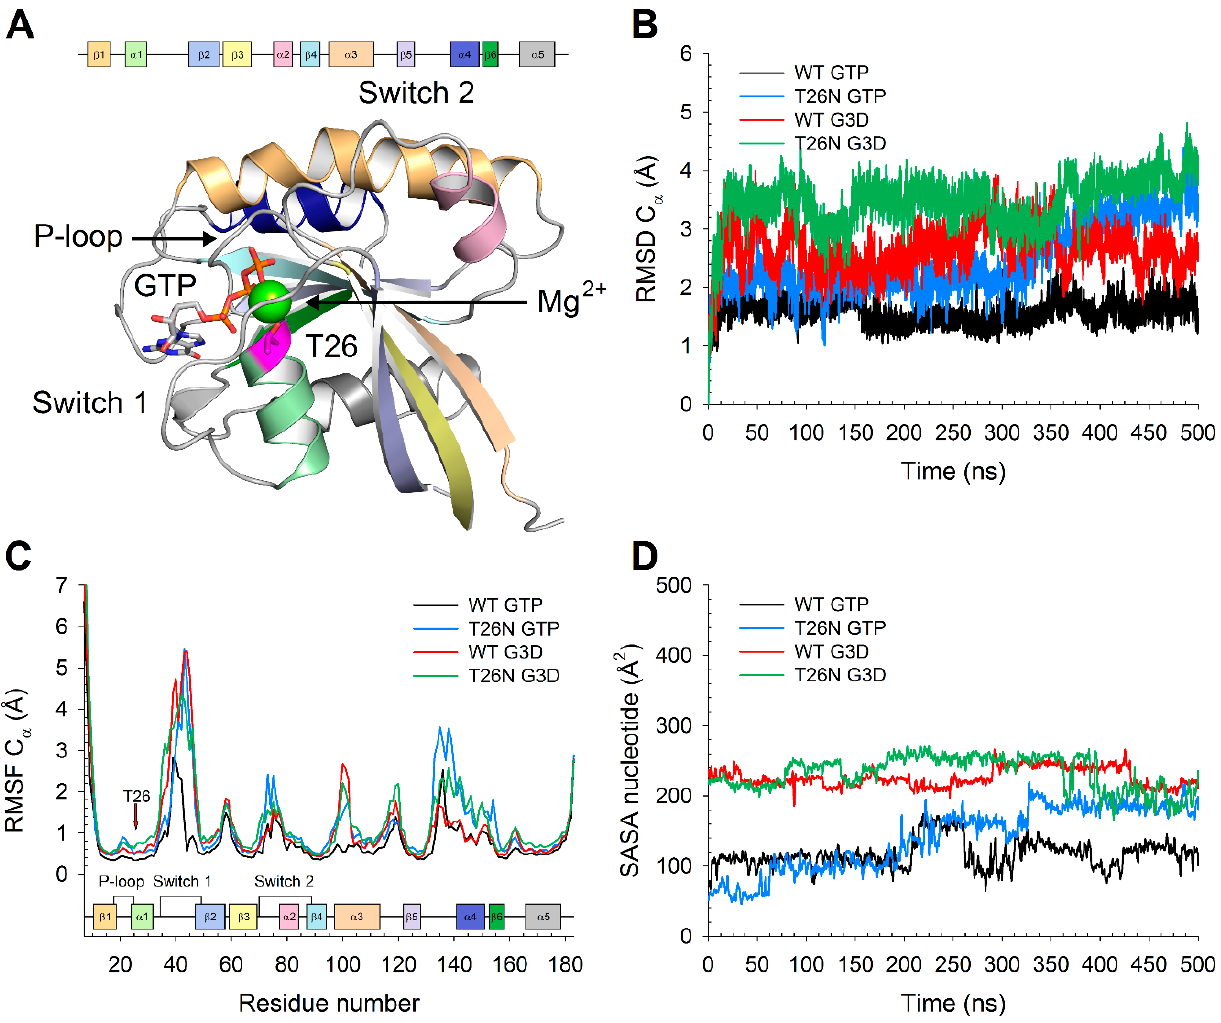
Figure 7. ( A ) The three-dimensional structure of GTP-bound Rab-28 is shown as cartoon, Mg 2+ -ion is shown as a green sphere, GTP is represented as sticks with C atoms in white, N atoms in blue, O atoms in red, and P atoms in orange, residue T26 is shown as magenta sticks with the O atom highlighted in red. The P-loop and the Mg 2+ ion are indicate by black arrows. Inset shows the coloring scheme for secondary structure elements. ( B ) Time evolution over 500 ns of the C α -RMSD of GTP-bound wild-type (WT) (black), GTP-bound T26N (blue), G3D-bound WT (red), G3D-bound T26N (green) Rab-28. ( C ) C α -RMSF profiles of GTP-bound WT (black), GTP-bound T26N (blue), G3D-bound WT (red), G3D-bound T26N (green) Rab-28. Inset shows secondary structure elements colored according to panel A, the position of residue 26 on the secondary structure representation is marked with a red arrow and labeled. ( D ) Time evolution over 500 ns of the SASA of guanine-nucleotide of GTP-bound WT (black), GTP-bound T26N (blue), G3D-bound WT (red), G3D-bound T26N (green) Rab-28. Data was smoothed using a moving average over 1 ns window as described in the methods